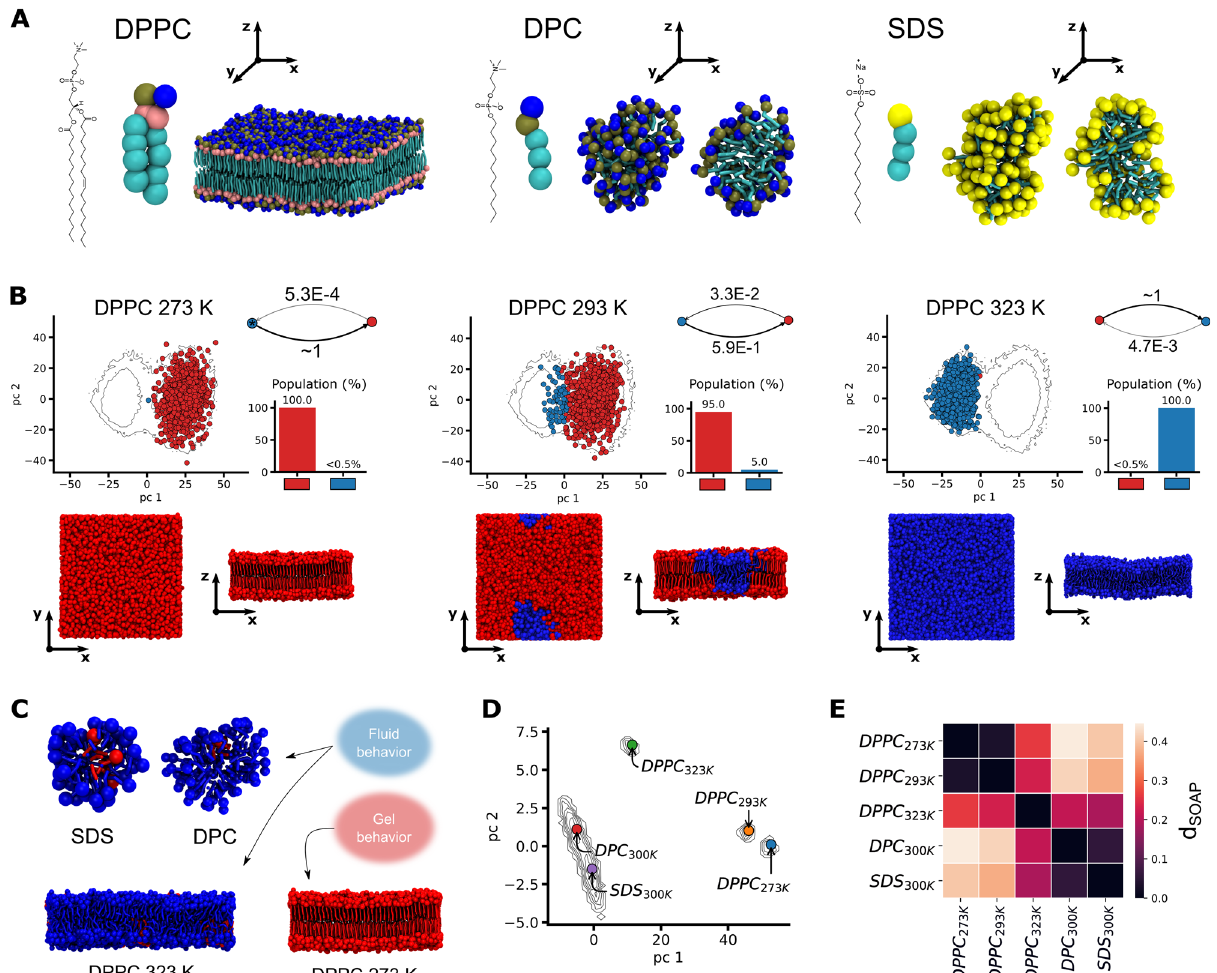
Fig. 4 Comparing 2D assemblies. We compare assemblies where the monomers are displayed on fl at (i.e., DPPC lipid bilayers) or curved/spherical surfaces ((i.e., DPC and SDS micelles). A Three example 2D assemblies (CG models for the monomers and their respective aggregates) considered herein. B SOAP + PAMM analysis for a DPPC lipid bilayer model at three different temperatures. For each value of T we report: the PC scatter plot of SOAP feature vectors (top-left), the molecular motifs (macroclusters) interconversion graph and population histogram (top-right), an equilibrium MD snapshot of the bilayer from top and side views (bottom). The scatter-plot circles and the lipids in the snapshots are colored according to the different motifs detected by PAMM analysis. C Equilibrium MD snapshots for each studied systems, with monomers colored according to the molecular motifs (macroclusters) detected in the analysis of the global dataset of the 2D aggregates (see Supplementary Fig. 10 for the individual PCA scatter plots). D Contour plot of the frame -average distributions, computed from the PCs of the SOAP vectors. The colored dots represent the simulation -averages for all considered assemblies in the PC reduced space. E Distance d SOAP matrix for all 2D